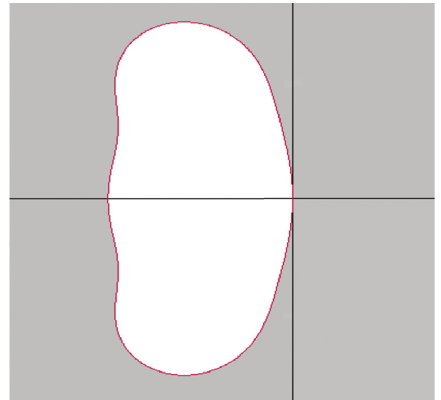
Figure 1: Stability region of the new proposed